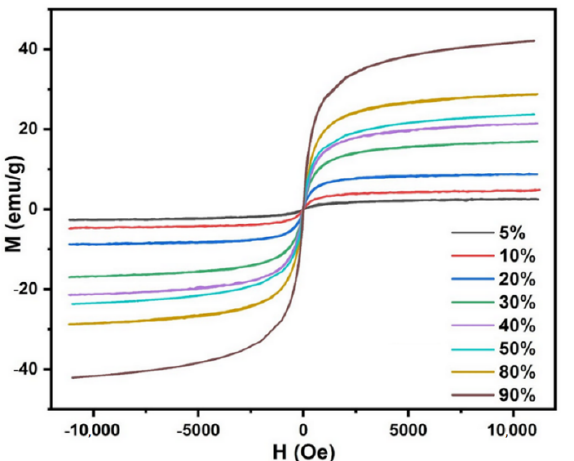
Figure 6. Magnetization curves of nanocomposites with different ratios SPION/HAp at 80 °C with pH 11.1.